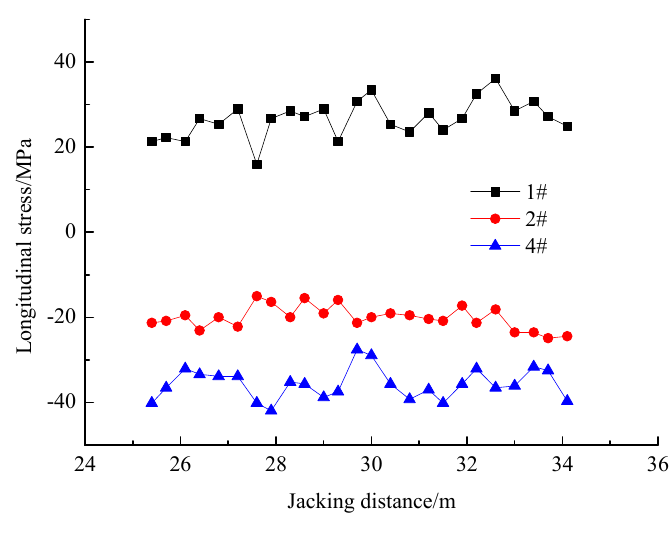
Figure 12. Longitudinal stress.